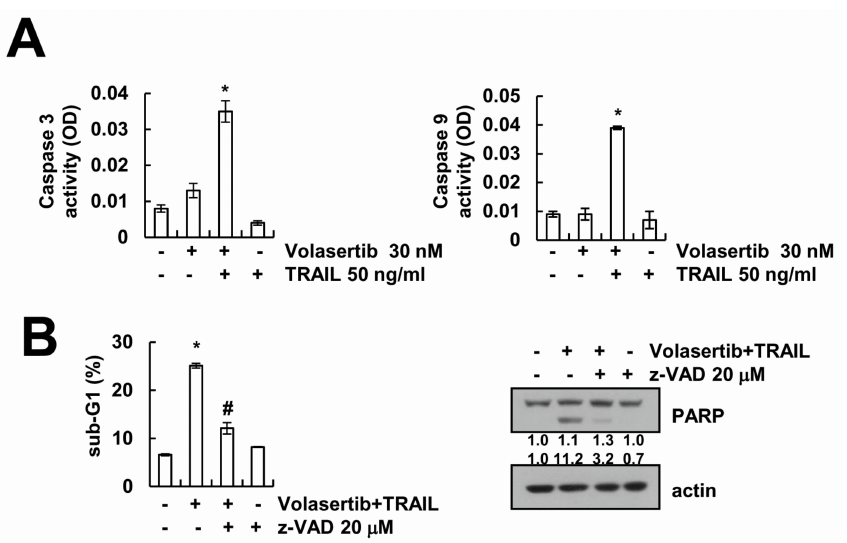
Figure 3. The combined treatment of volasertib and TRAIL induces caspase-mediated apoptosis in Caki cells. ( A ) Caki cells were treated with 30 nM volasertib plus 50 ng/mL TRAIL for 24 h. Caspase activities was determined with colorimetric assays using caspase-3 DEVDase or caspase-9 LEHDase assay kits. ( B ) Caki cells were treated with 30 nM volasertib plus 50 ng/mL TRAIL in the presence or absence of 20 µ M z-VAD-fmk (z-VAD) for 24 h. The sub-G1 fraction was detected via flow cytometry. The expression of PARP and actin were determined via Western blotting. The values in graphs ( A , B ) represent the mean ± SD from three independent samples. * p < 0.01 compared to the control. # p < 0.01 compared to volasertib plus